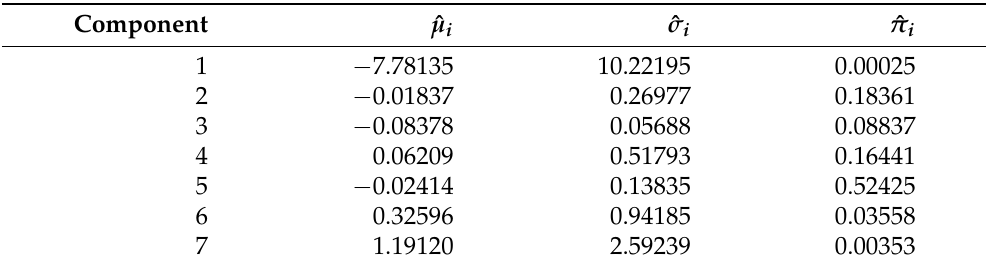
Table 2. Estimated parameters for each component of the finite mixture model based on 7 normal